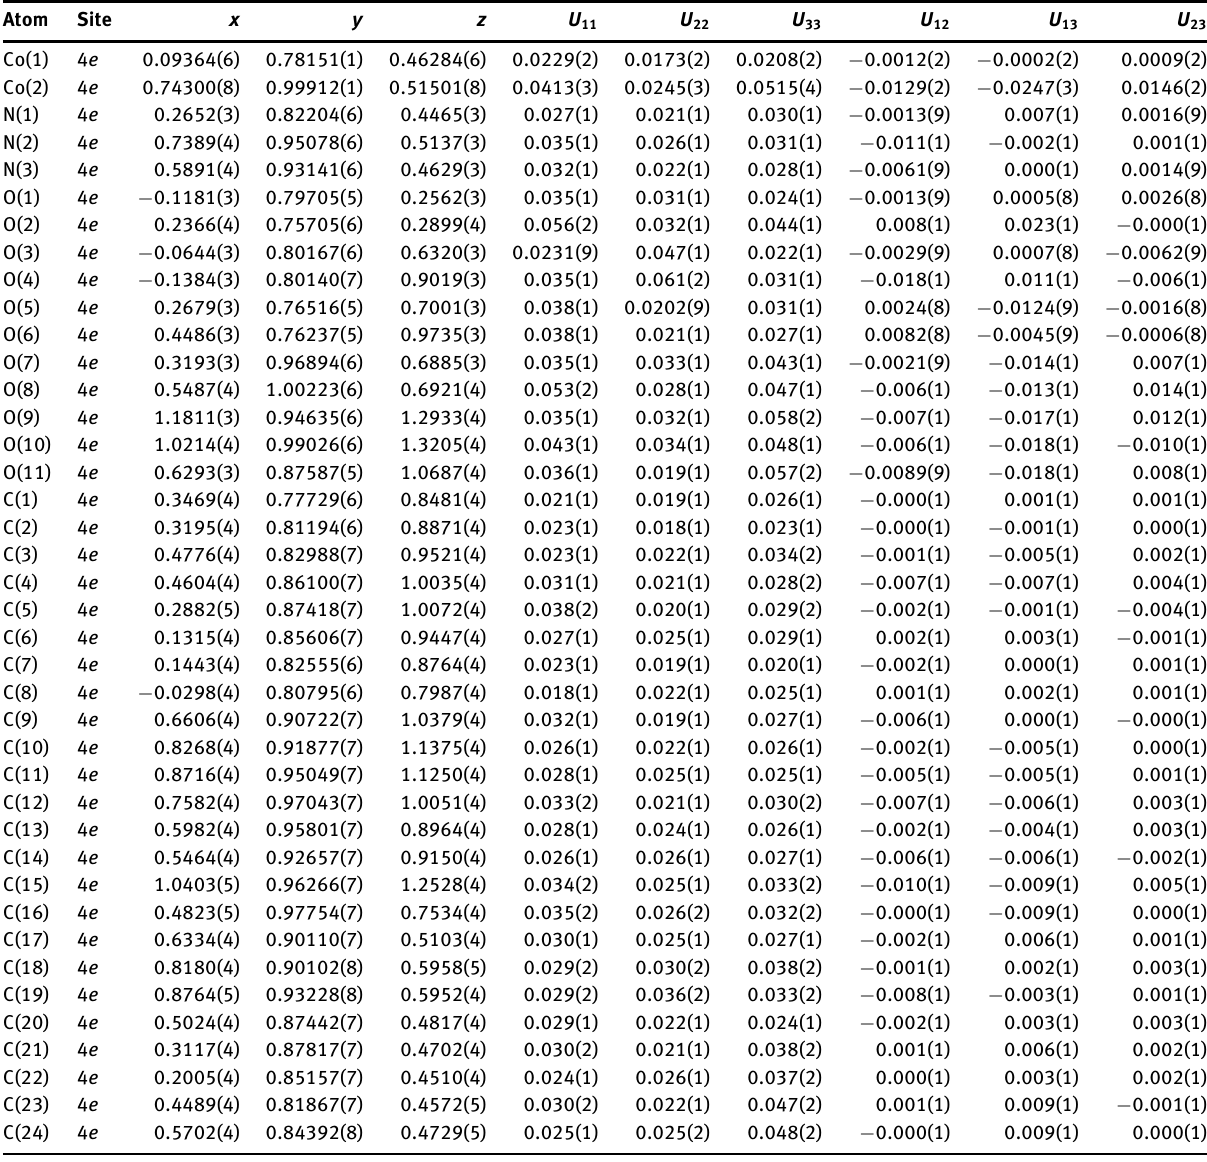
Table 3: Atomic displacement parameters (Å 2